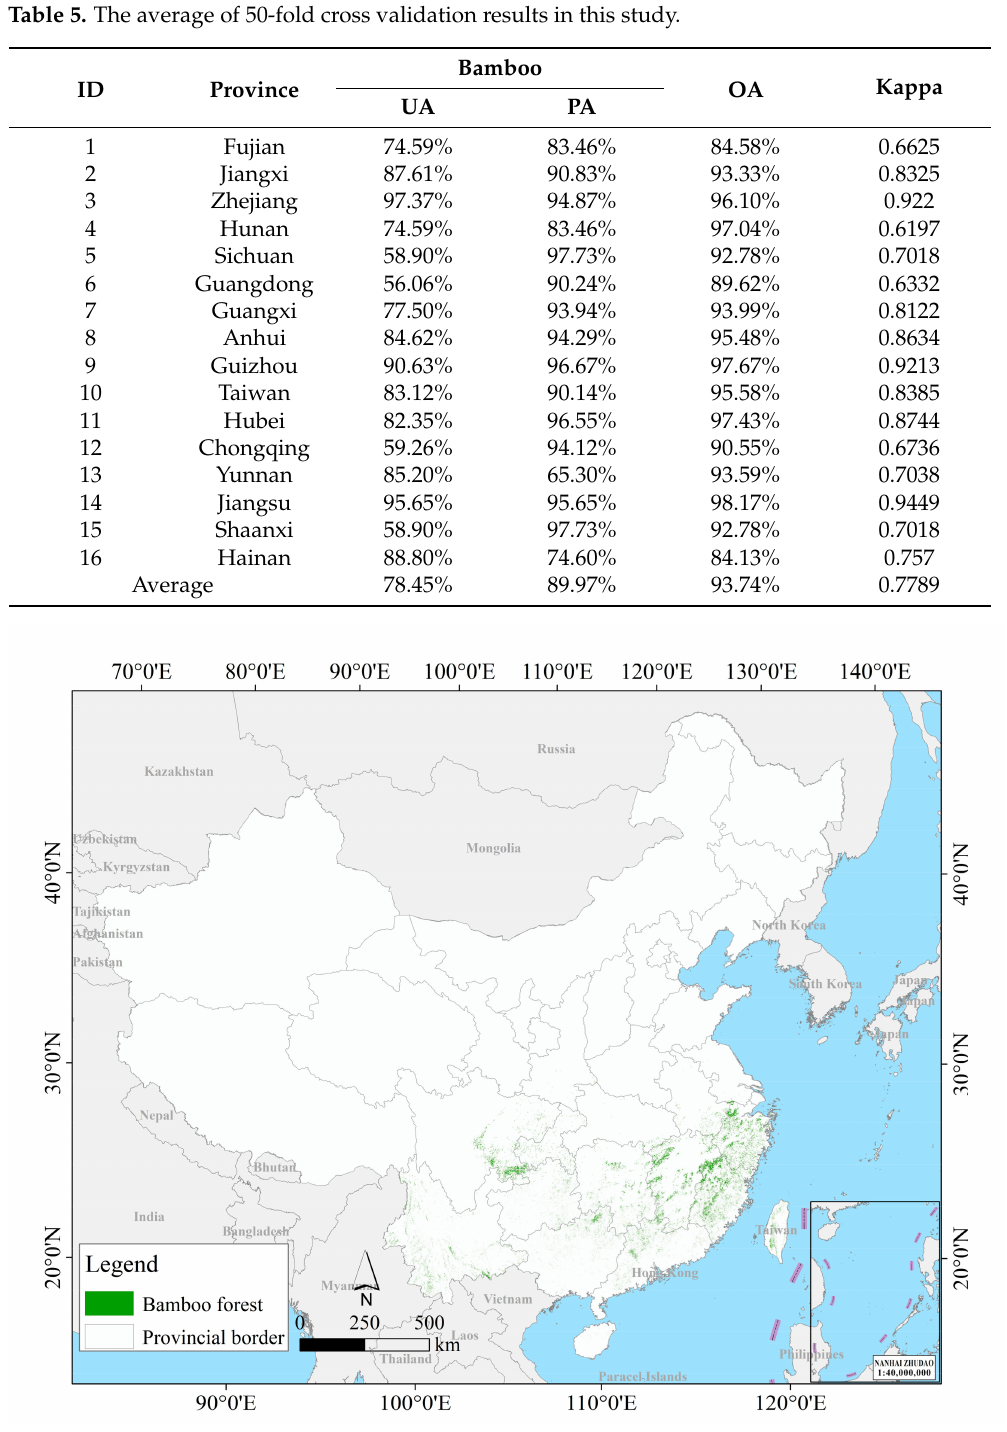
Figure 4. Spatial distribution map of bamboo in China that we obtained using the Landsat 8 time- series image